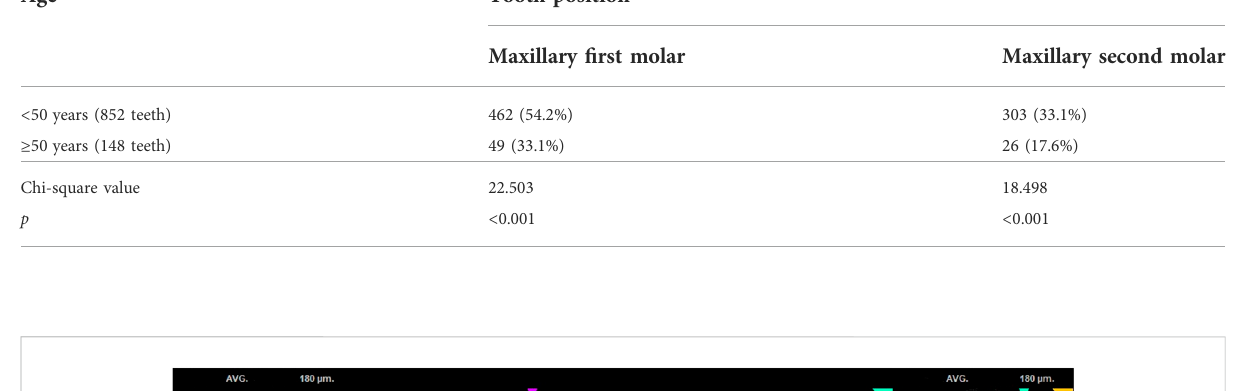
TABLE 3 Comparison of the incidence of MB2 of maxillary molars between two groups divided by age.